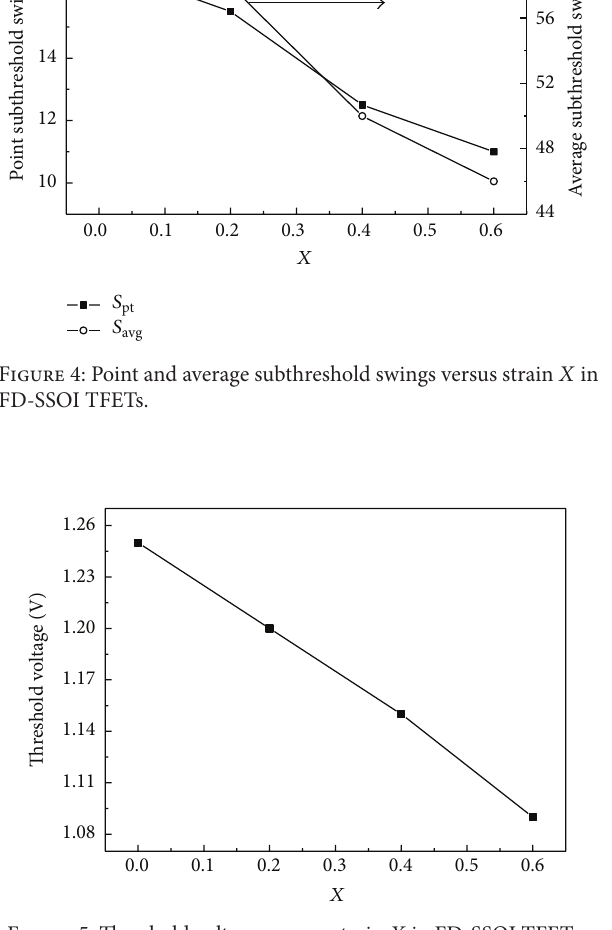
Figure 5: Threshold voltages versus strain 𝑋 in FD-SSOI